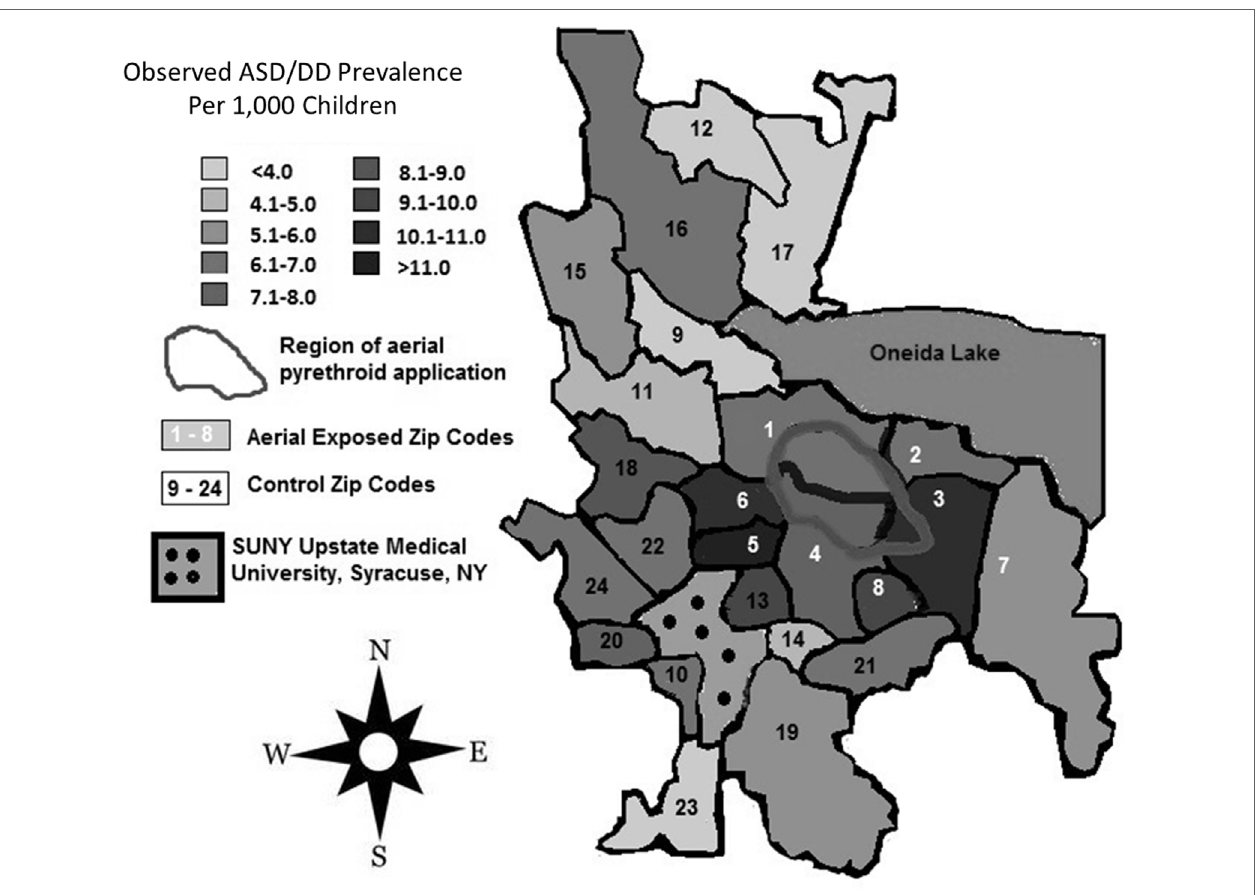
FigUre 2 | regional rates of autism spectrum disorder (asD) and developmental delay (DD) diagnoses . Total numbers of children diagnosed with ASD/ DD in each zip code were identified with a retrospective review of records at the State University of New York (SUNY) Upstate Regional Medical Center, and prevalence rates were calculated using publicly available American Community Survey data for each zip code. Zip codes exposed to aerial pyrethroid pesticides had a higher prevalence of ASD/DD than control zip codes with standard pesticide application methods.